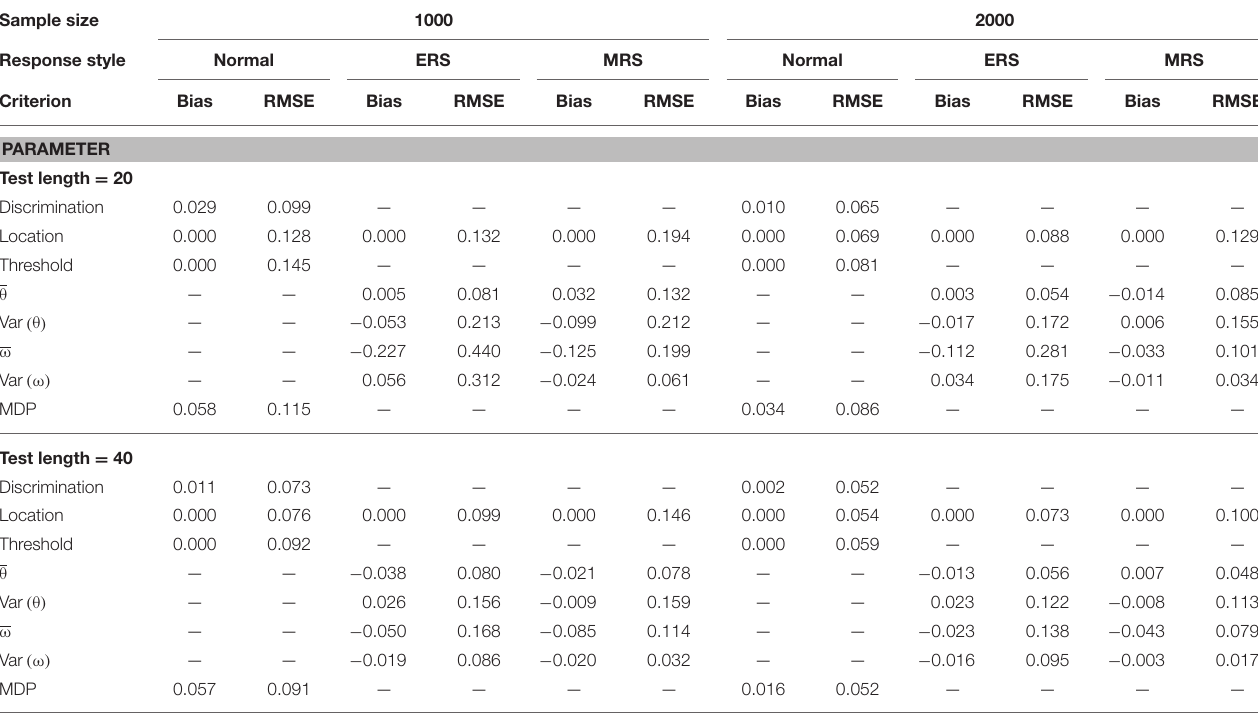
TABLE 3 | Mean bias and RMSE of the model parameter estimates for the mixture ERS-GPCM-CD on 4-point items. Sample size